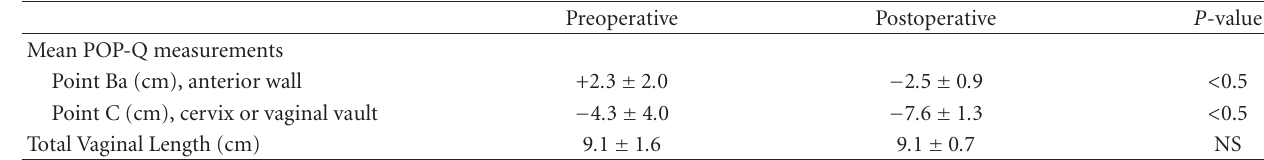
Table 3: Preoperative versus postop POP-Q measurements